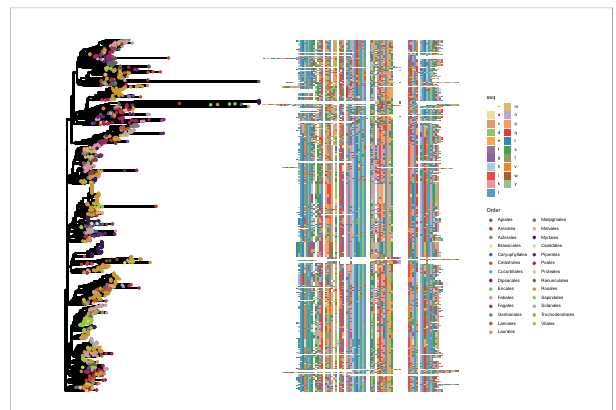
FIGURE 6 Phylogenetic analysis of group CNL. The left panel shows the phylogenetic tree created using FastTree, with different colors denoting different orders. The right panel shows the corresponding aligned domain sequences, with different colors corresponding to different amino acids.